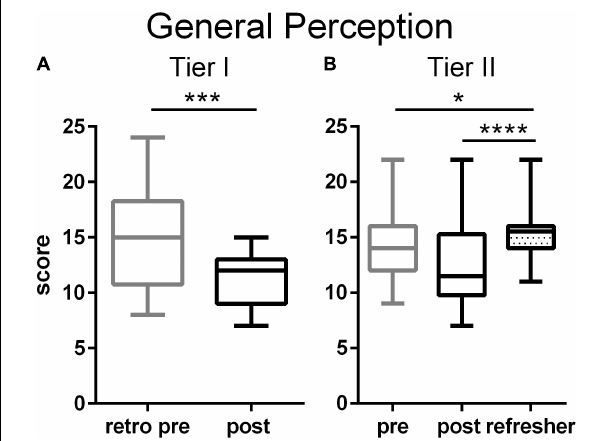
FIGURE 2 | General Perceptions of people with MI among Tier I (A) and Tier II (B) teachers. Tier I teachers significantly reduced negative attitudes toward people with mental illness after the training ( p = 0.0007, Cohen’s d = –1.09, two tailed t -test). Among the Tier II teachers, negative attitudes declined only as a trend after the training, but rose significantly at the time of the Refresher ( p < 0.0001, η 2 = 0.15, one way ANOVA with Tukey’s multiple comparison post-test). Boxes represent 25th to 75th percentiles with an internal bar at the median. Whiskers delineate maximum and minimum data points. Tier I N = 22 retrospective pre, 23 post, Tier II N = 44 pre, 38 post, 56 Refresher. For the post tests, *, ***, **** represent p < 0.05, 0.001, 0.0001, respectively.